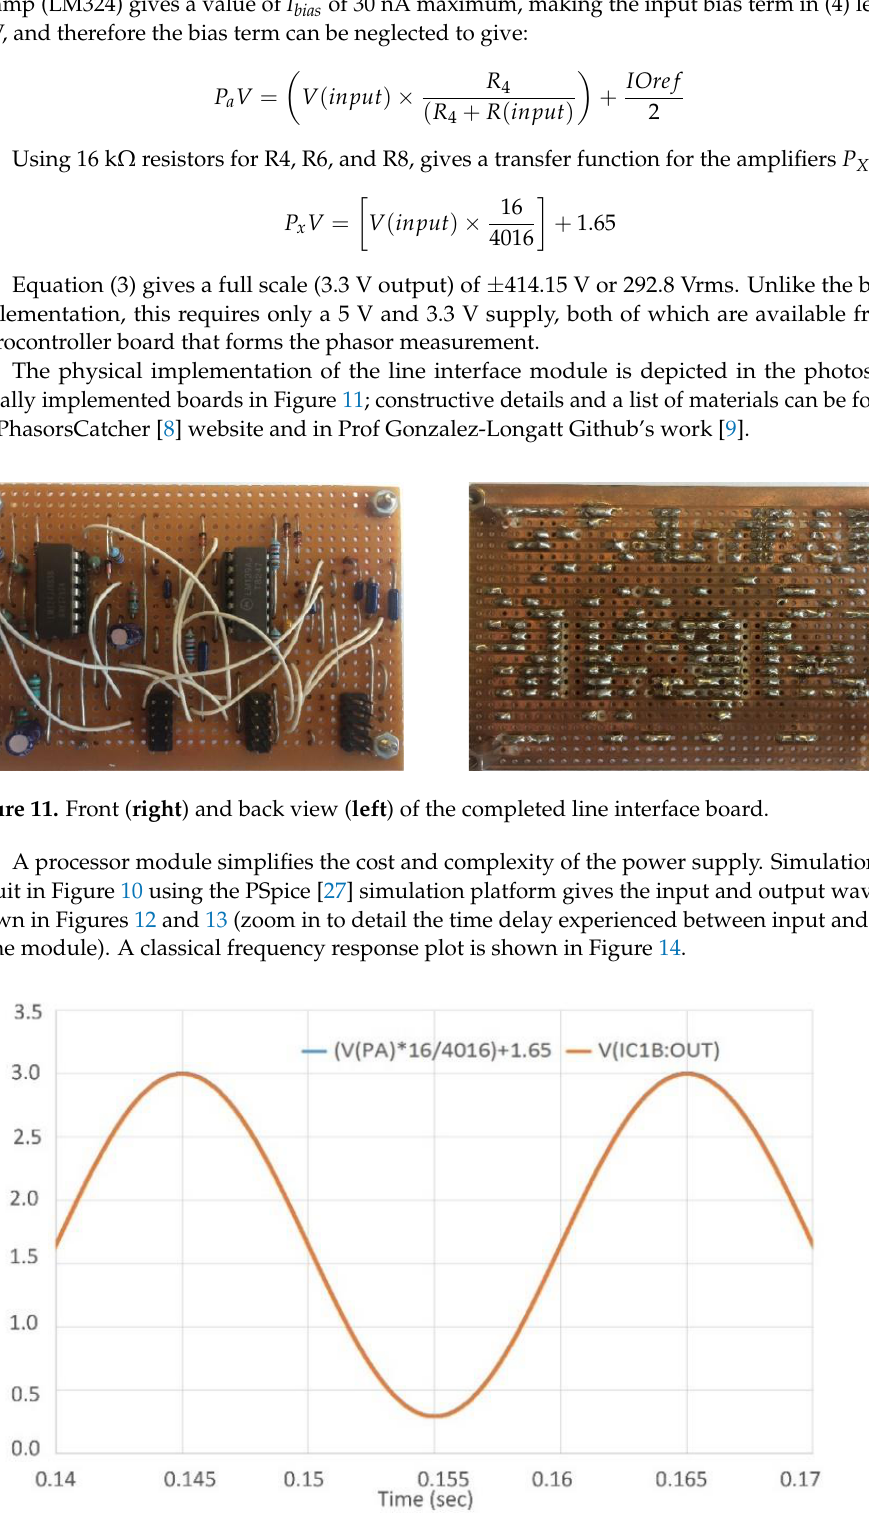
Figure 12. Line voltage circuit simulation response. The blue colour is the input, and the orange colour is the output.